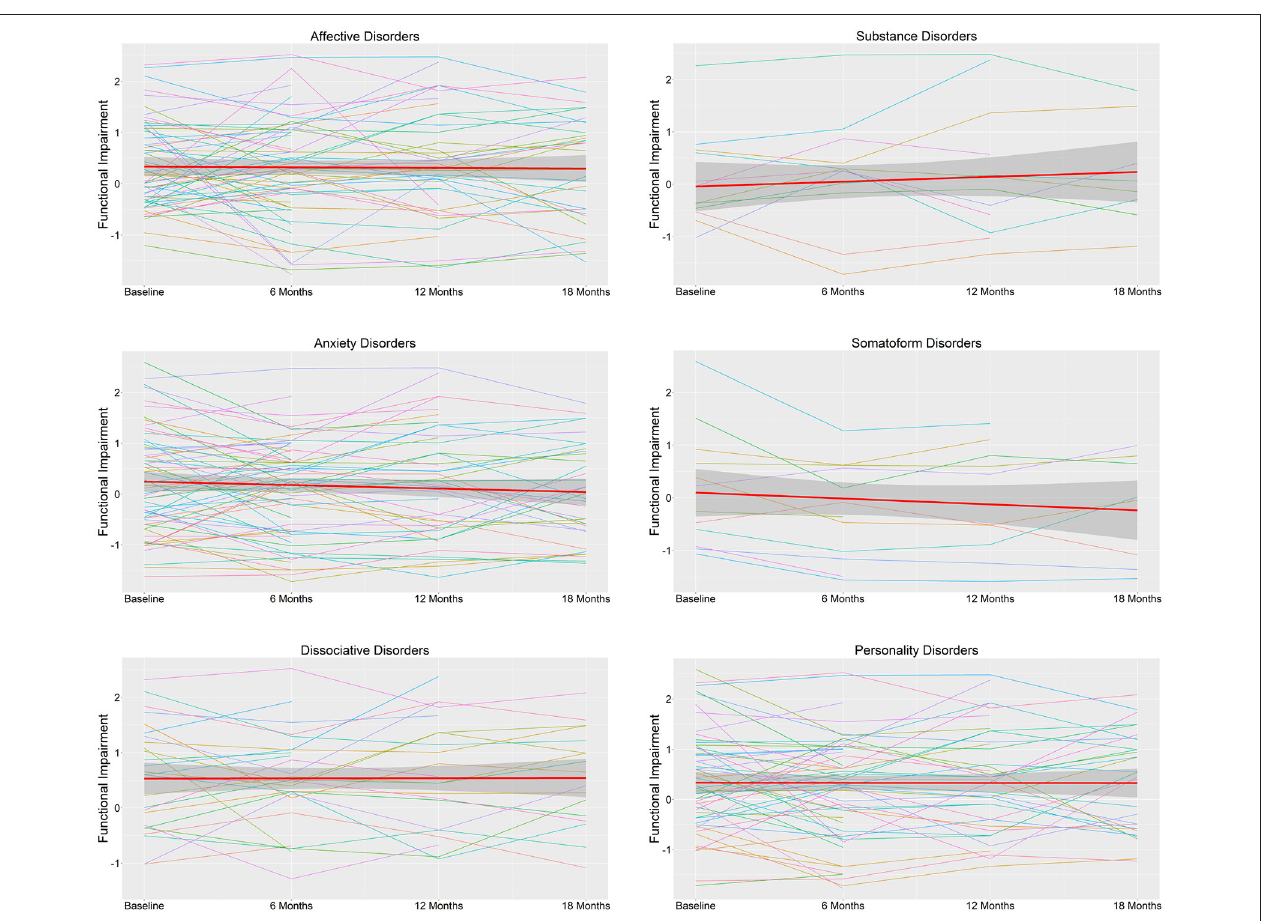
FIGURE 1 | Functional impairment across WHODAS II domains during 18 months in outpatients and day-care patients ( N = 155) by DSM-IV diagnostic category. The thick red line represents the mean functional impairment score and the associated ribbon the standard deviation. The colored thin lines represent functional impairment scores of individual cases. Higher scores represent higher impairment across life